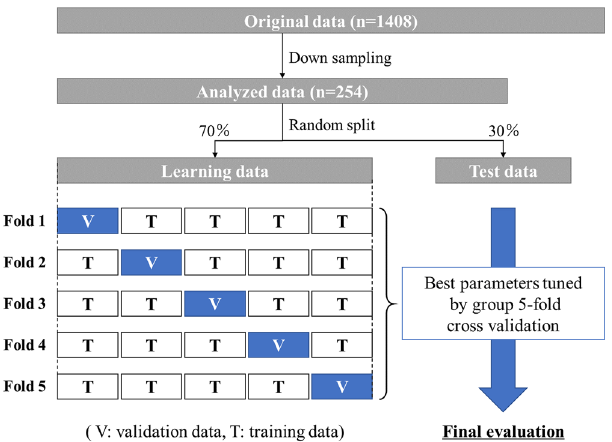
Figure 5. Experimental workflow of predictive machine learning approach. This figure was created with PowerPoint 2019 version 1808 (Microsoft, Inc, Redmond,